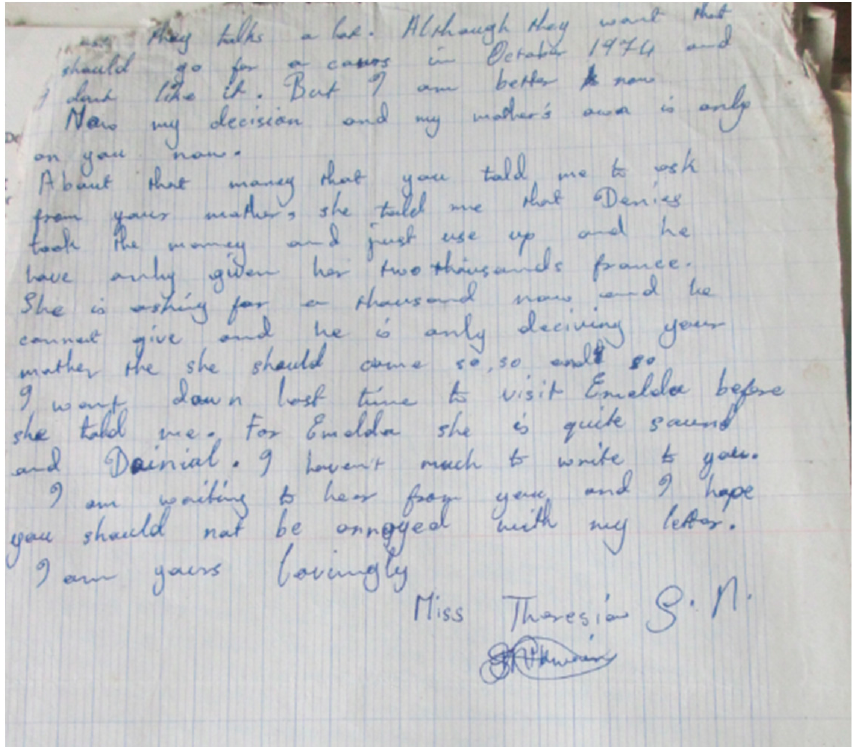
Figure 4. A letter showing tension because of money.